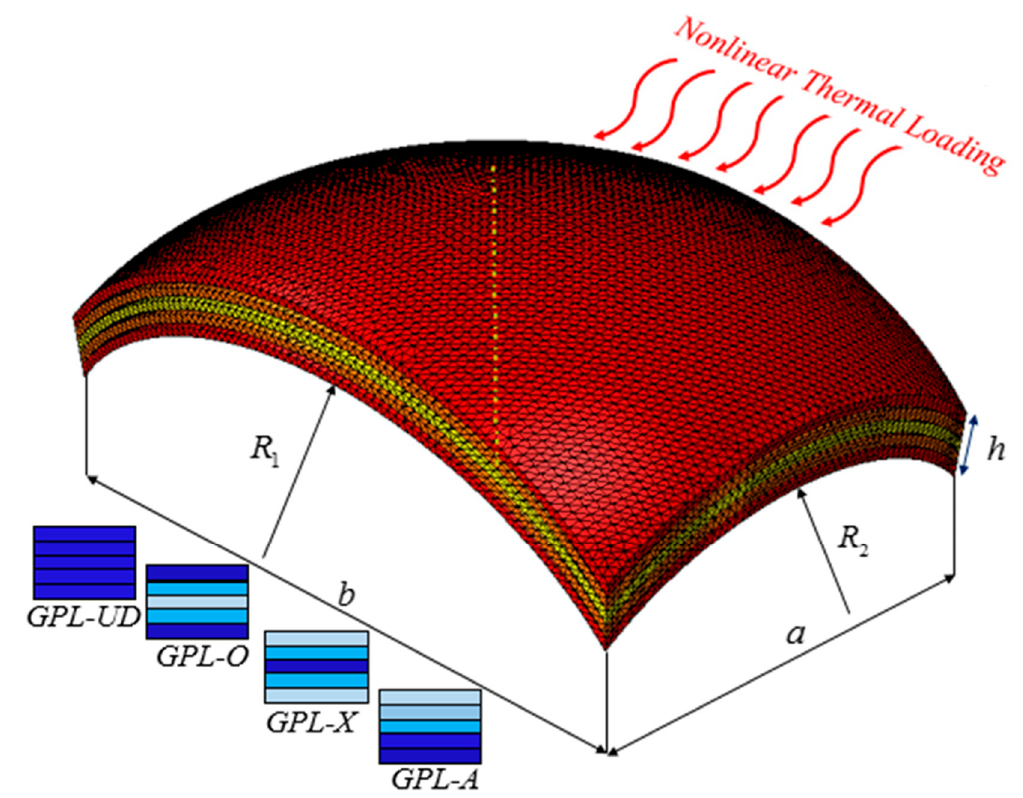
Figure 1. Schematic of a graphene nanoplates-reinforced composite (GPLRC) cylindrical panel subjected to thermal loading.